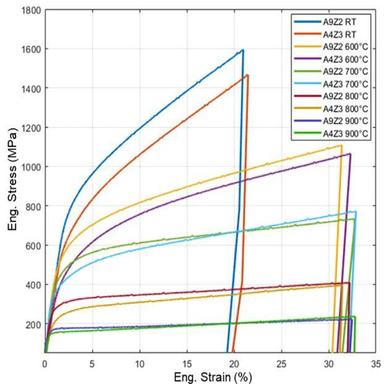
Engineering stress-strain curves of the in-situ HEXRD compression on A4Z3 and A9Z2 for RT, 600 °C, 700 °C, 800 °C, and 900 °C. For colors, please see digital version.